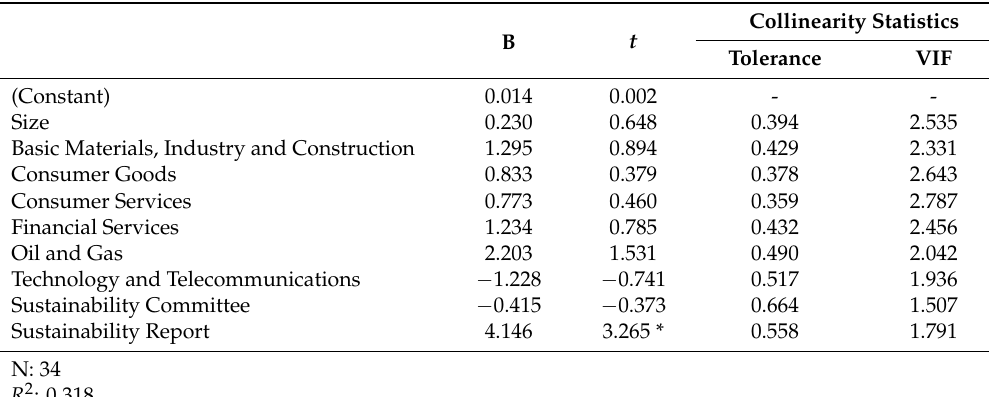
Table 10. Social Matters Index as Dependent Variable.